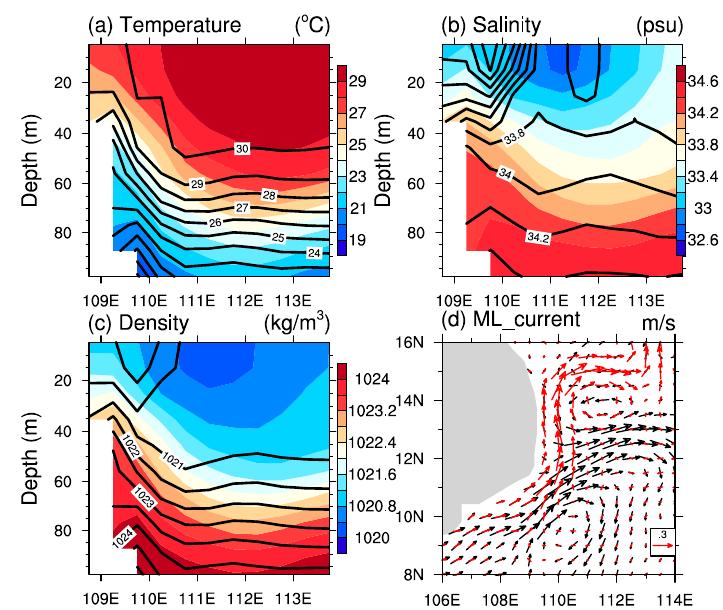
Figure 5. Temperature along the transect during August in 1998 (contour, units: ◦ C) and 2016 (shading, units: ◦ C). ( b ) Same as in ( a ) but for the results of salinity (units: psu). ( c ) Same as in ( a ) but for the results of density (units: kg / m 3 ). ( d ) Spatial distribution of the mixed-layer horizontal currents during August in 1998 (red vector, units: m / s) and 2016 (black vector, units: m / s).